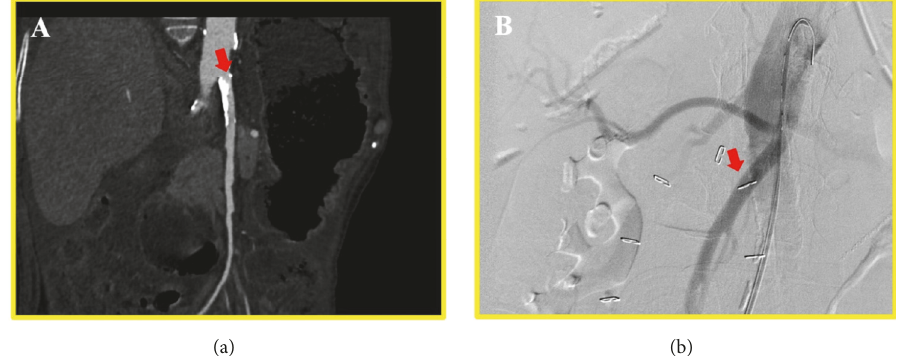
Figure 3: CT angiography abdomen revealed stenosis of mesenteric artery (a). Arteriogram indicated patent mesenteric artery (b). Arrow: mesenteric